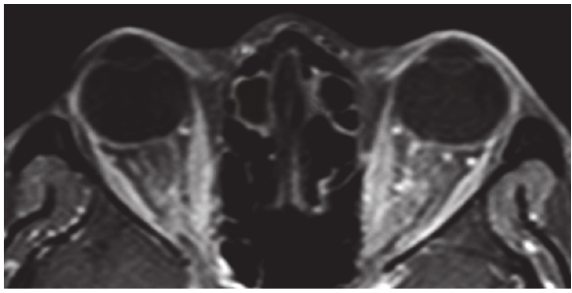
Figure 4: Contrast-enhanced MR images showing marked enhancement of the optic nerve sheath on axial view (tram track sign). Slight tortuosity of the optic nerve is seen on the right side.